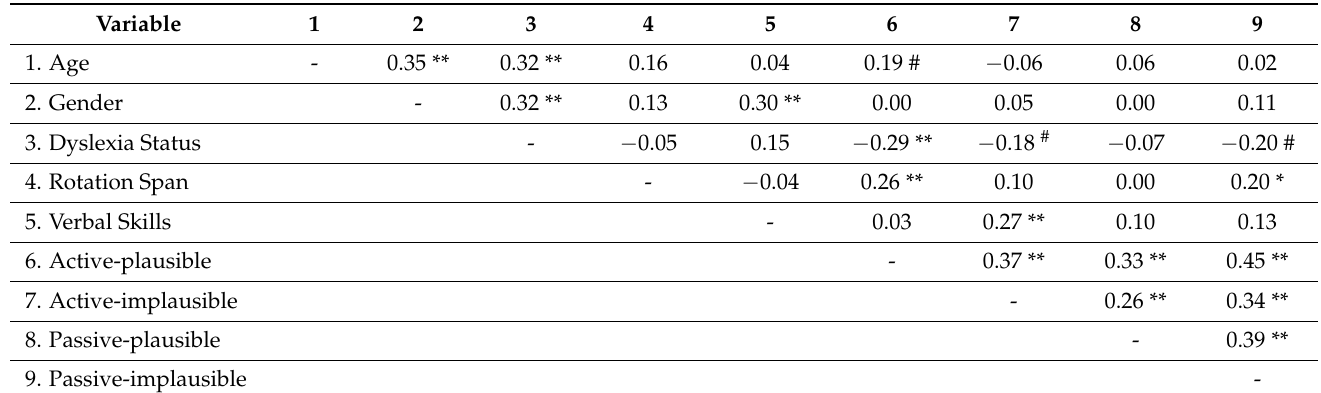
Table 3. Bivariate correlations between demographics, working memory, verbal skills, and compre- hension.